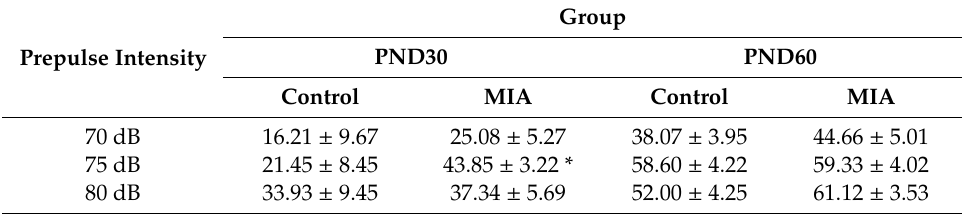
Table 2. The e ff ect of MIA on the prepulse inhibition of the acoustic startle response (PPI) in